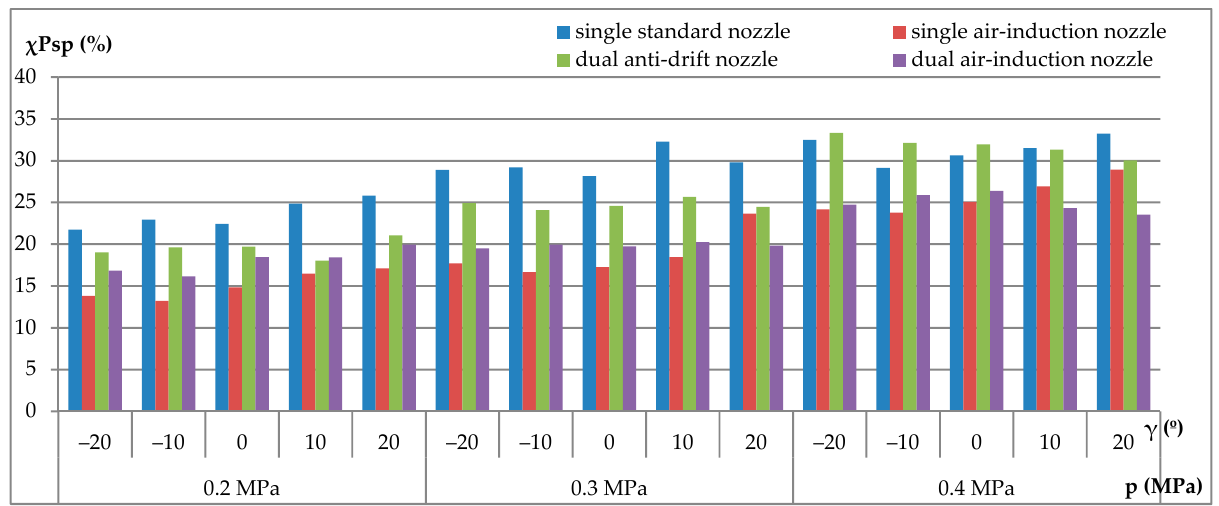
Figure 4. Average degree of coverage for selected nozzles at 3.3 m ∙ s − 1 driving speed.